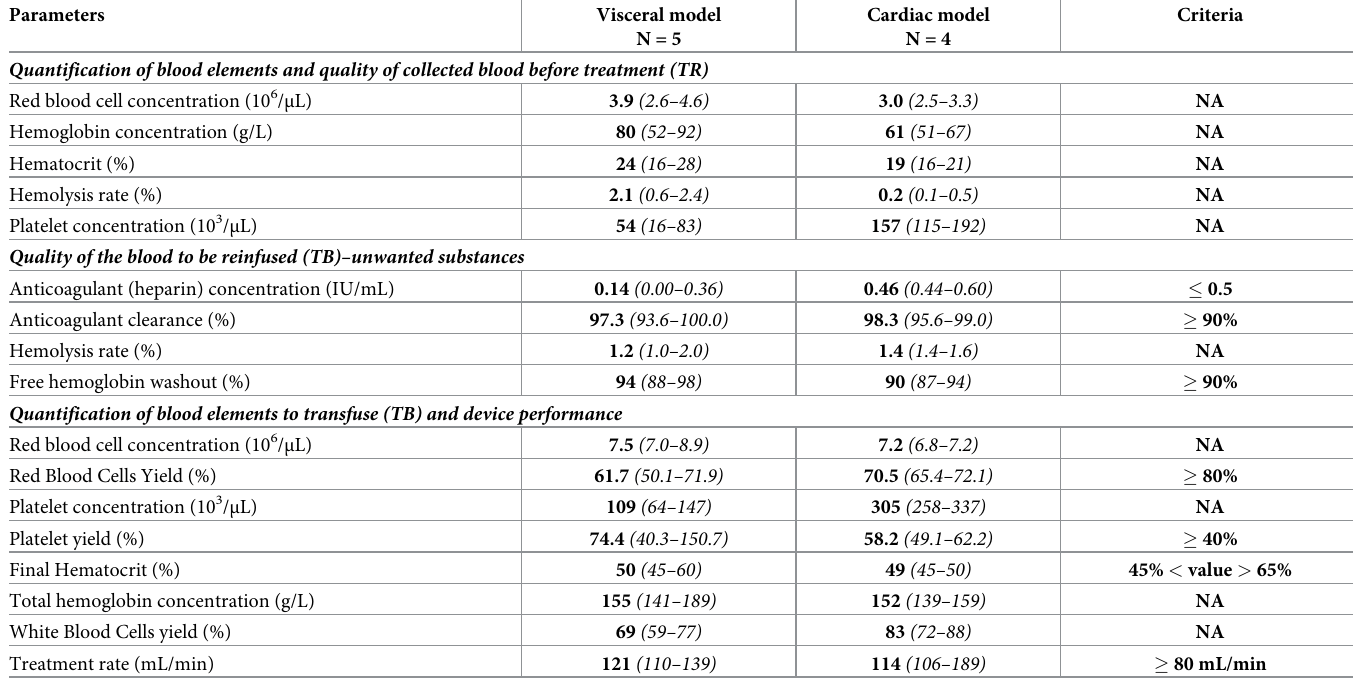
Table 4. Qualitative and quantitative assessment of the autotransfusion